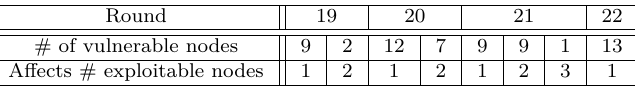
Table 12: Results for SPECK32/64 implementation.